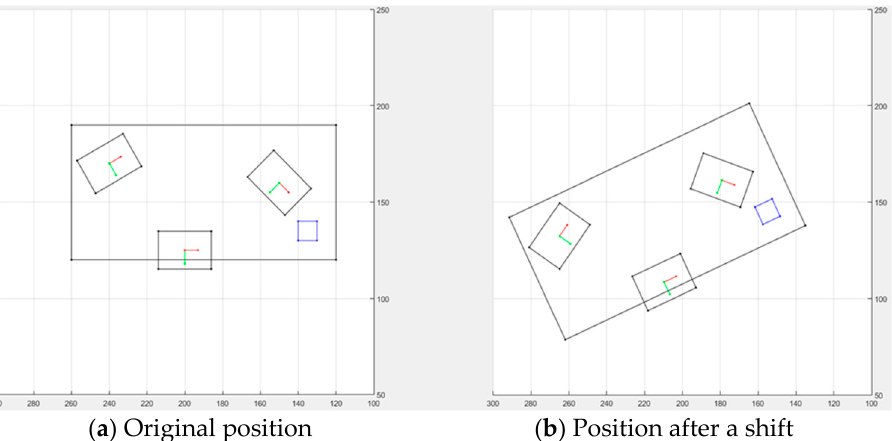
Figure 8. Simulation results of the position correction system. The large black rectangle represents the entire object (computer server board); the blue rectangle is the artificial marker; the three black intermediate size rectangles represent the AOI capture position of the camera; the red and green lines represent the camera’s plane coordinates used to capture the AOI images and the camera coordinate axis, respectively.